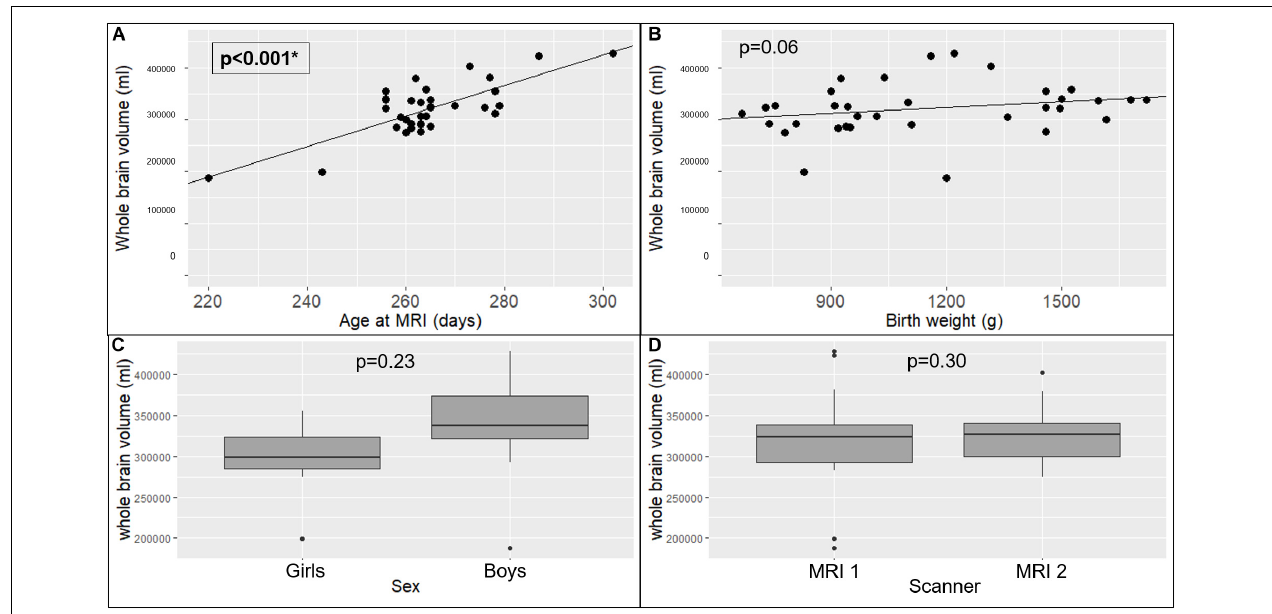
FIGURE 3 | Effects of explanatory variables included in the multiple linear regression model on whole brain volume: age at MRI (A) , birth weight (B) , sex (C) , and MRI scanner used (D) . The significant p -values are in bold characters within a square frame.